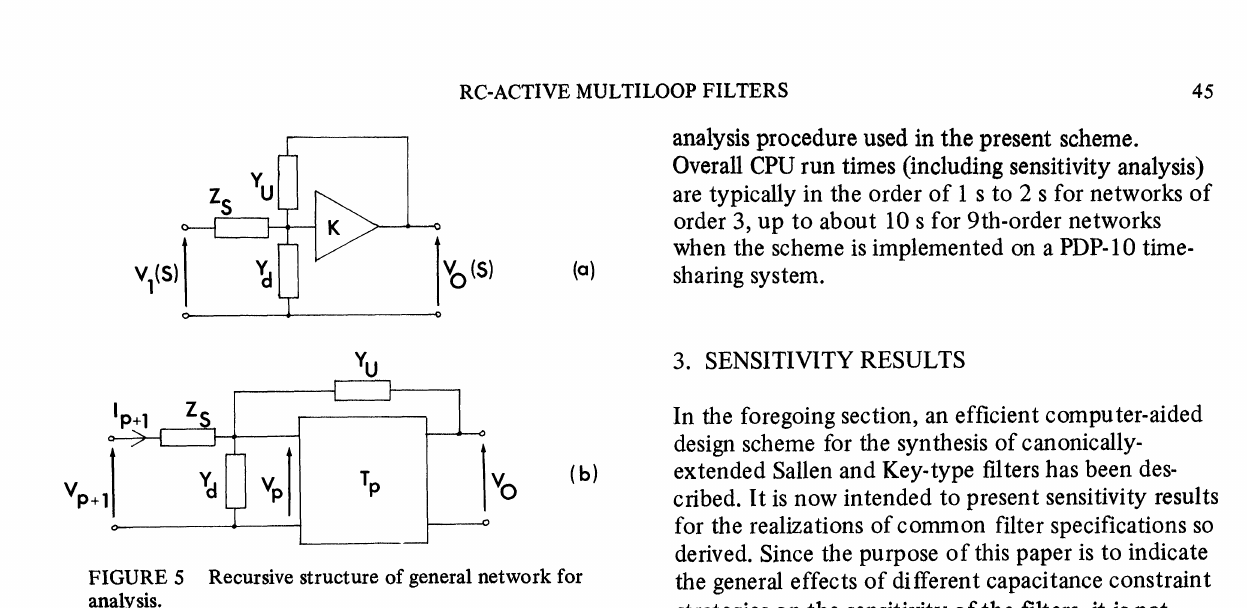
Recursive structure of general network for